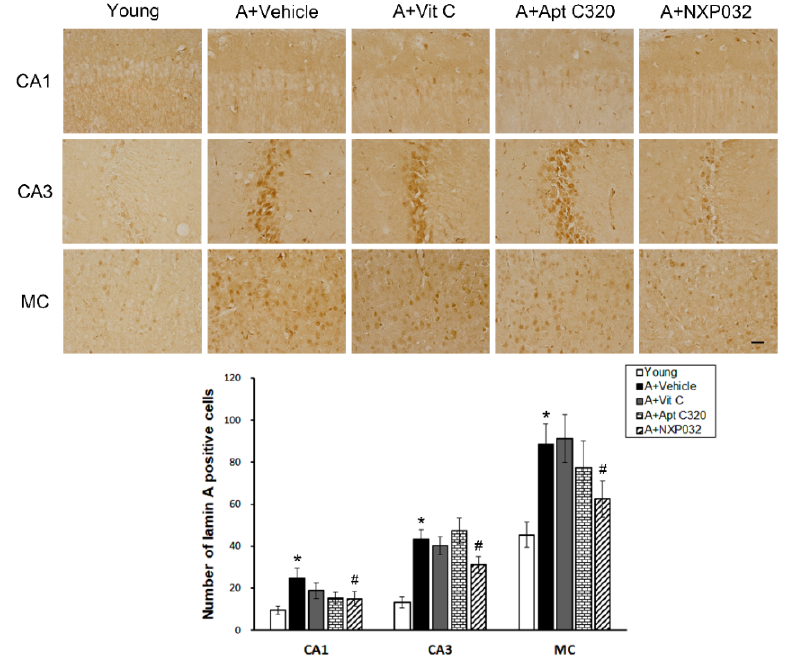
Figure 4. Effect of NXP032 on aging-induced lamin A in the brain. Representative photographs of immunostaining of lamin A in the hippocampal CA1, CA3, and MC regions. The aging mice had a significantly higher number of lamin A in the hippocampal CA1, CA3, and MC regions. NXP032-